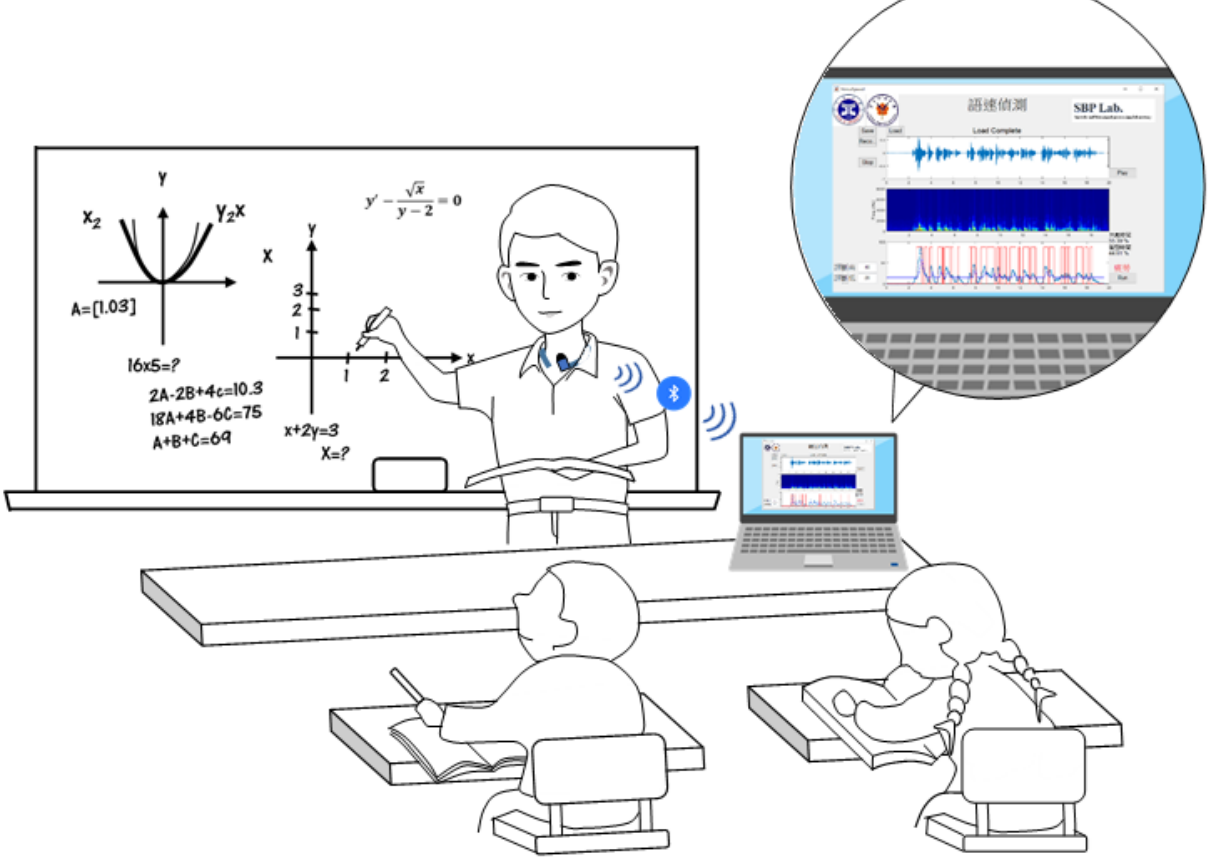
Figure 11. Exemplary use of the automatic speech detection system by a